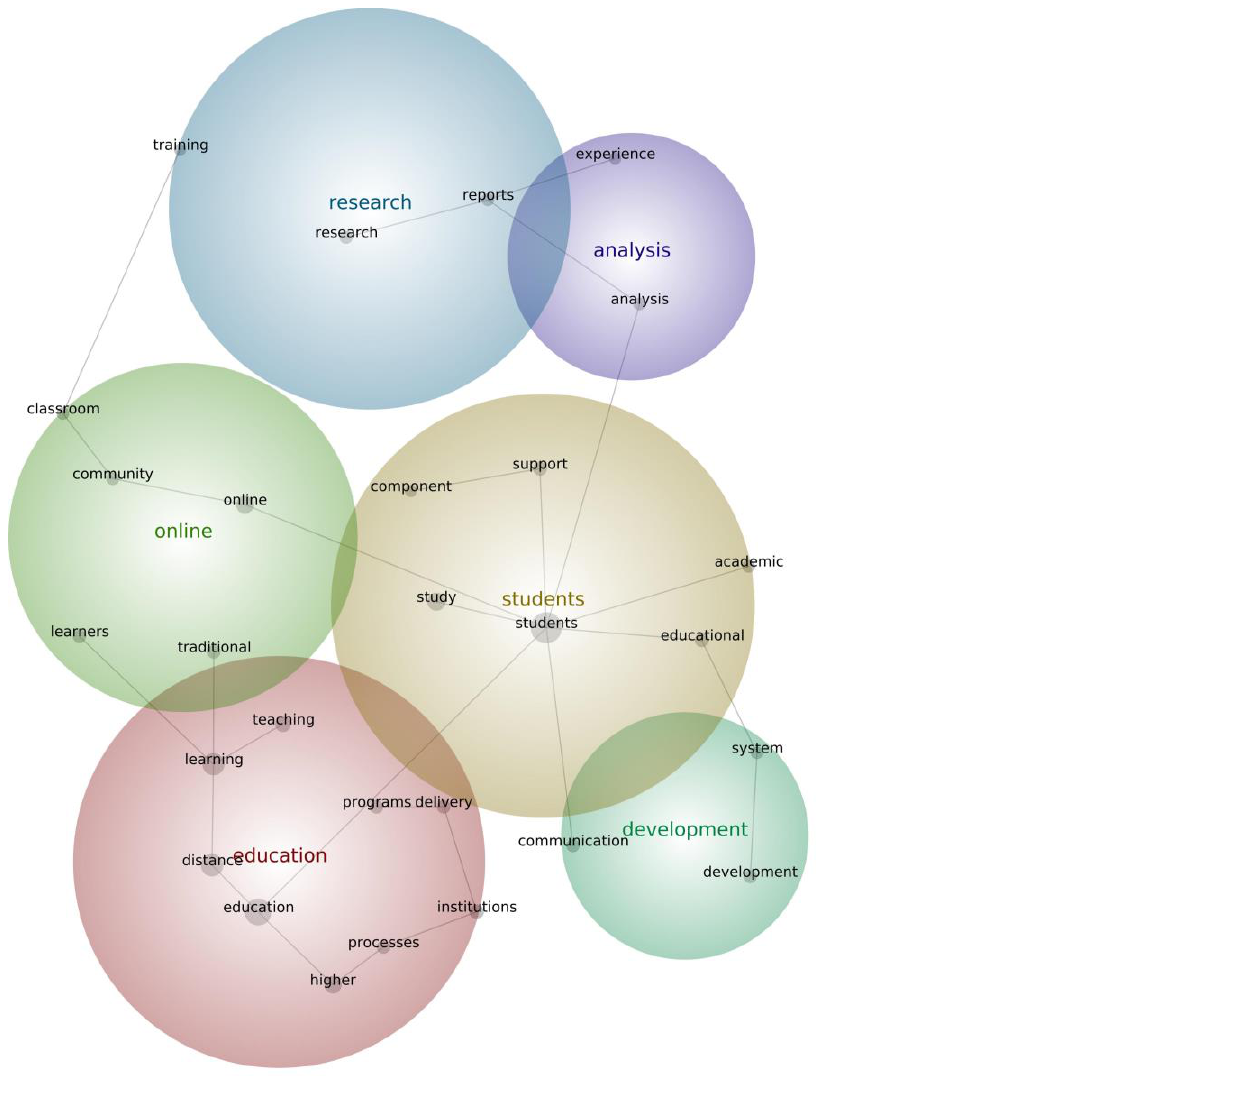
Figure 2. Concept map of online learning and distance education institutions